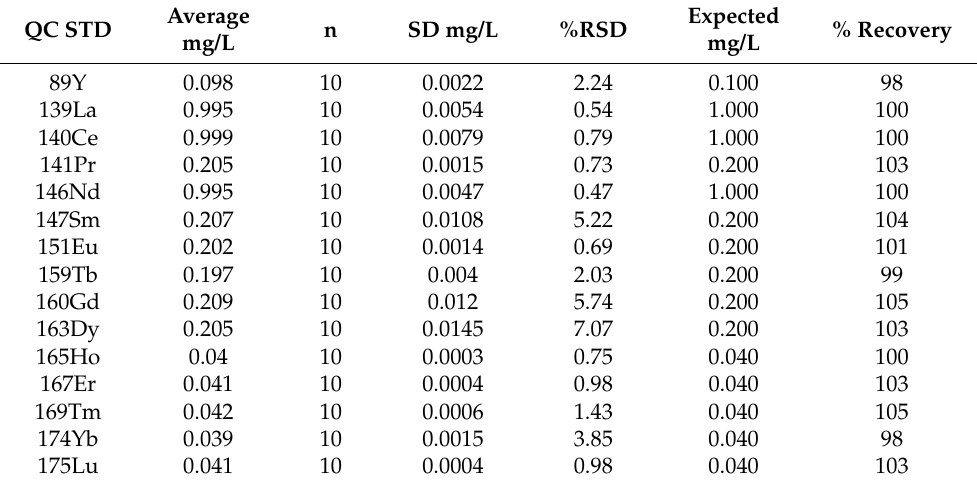
Table 5. Repeatability and stability evaluated REE quality control